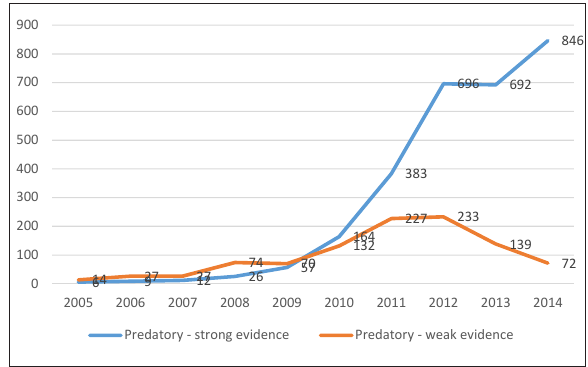
Figure 1: Increase in number of papers published by South African authors in predatory journals